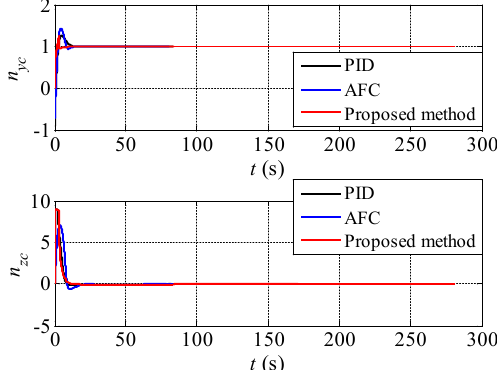
Figure 9. The aiming error angles of the UCAV during the process of attack guidance.